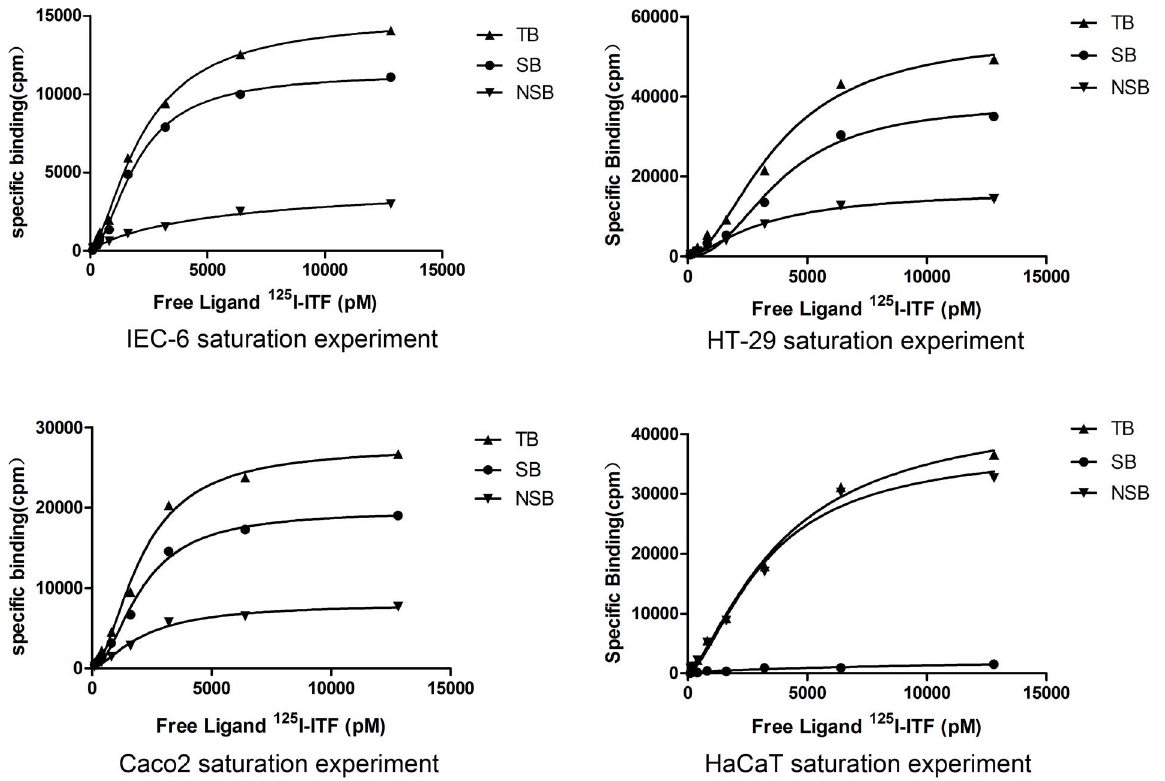
Figure 1. Analyses of binding of ITF to intestinal epithelial cells and to epidermal cells.